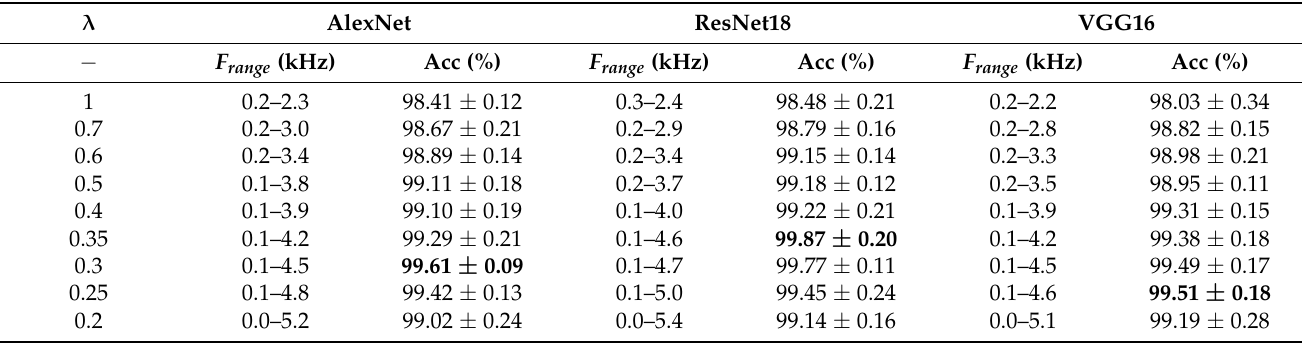
Table 4. Results of different λ on